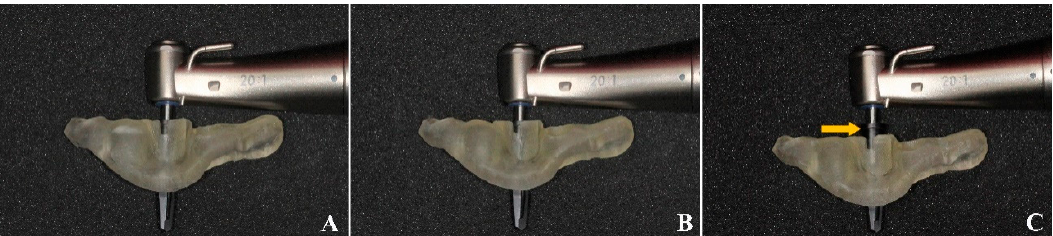
Figure 5. Evaluation of the fabricated surgical guides. ( A ) Surgical guide with 5.19 mm diameter. ( B ) Surgical guide with 5.18 mm diameter. ( C ) Surgical guide with 5.17 mm diameter.